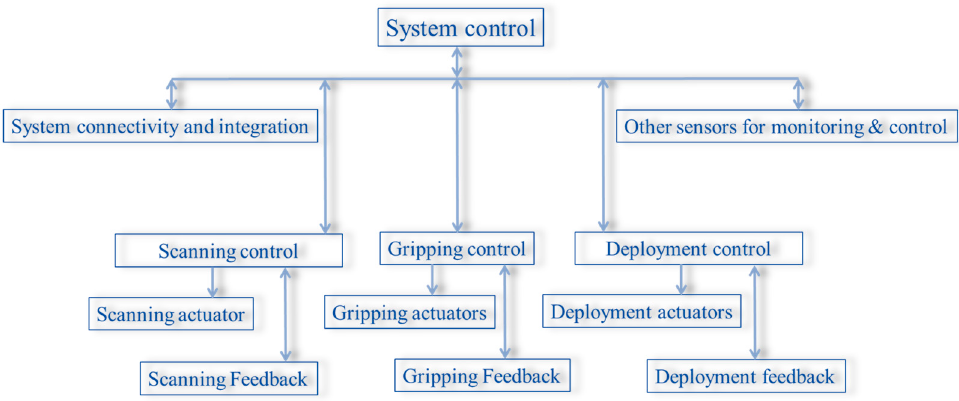
Figure 2. System configuration components.